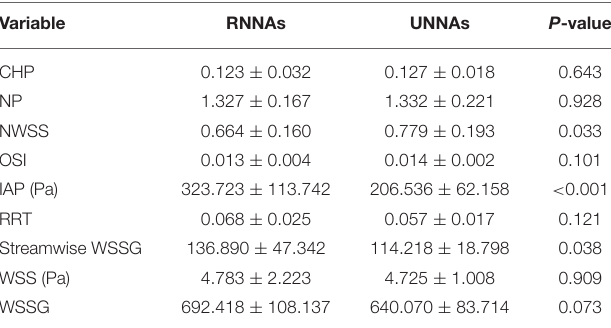
TABLE 5 | Results of hemodynamic parameters between RNNAs and UNNAs. Variable